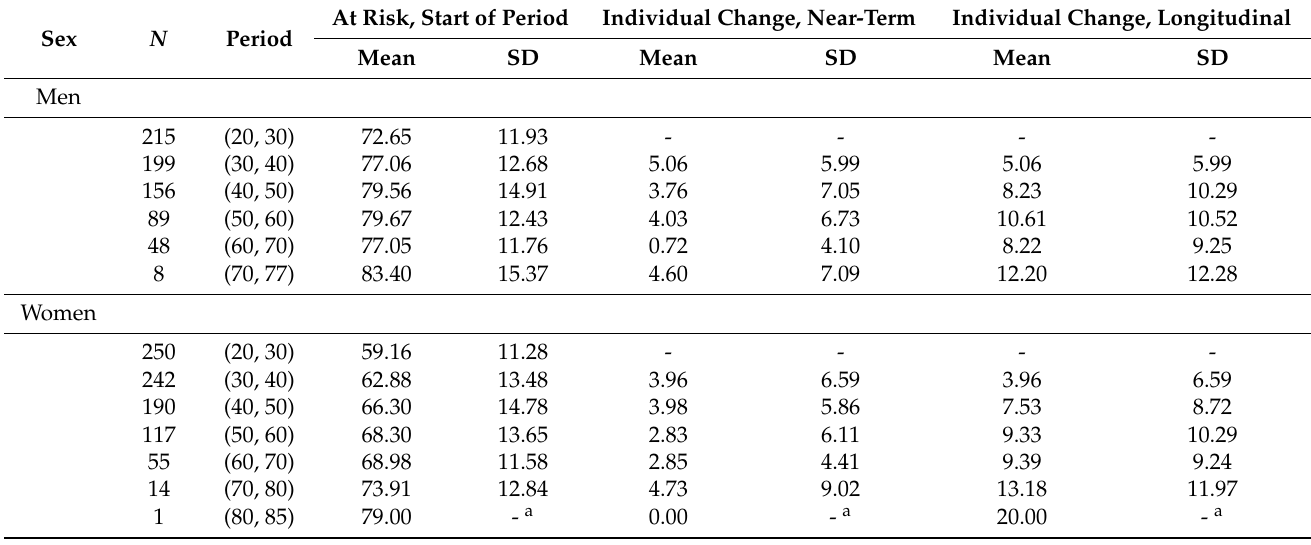
Table 3. Means and standard deviations for weight measurements (kg) and individual weight change in 10-year periods among participants with Lynch syndrome.